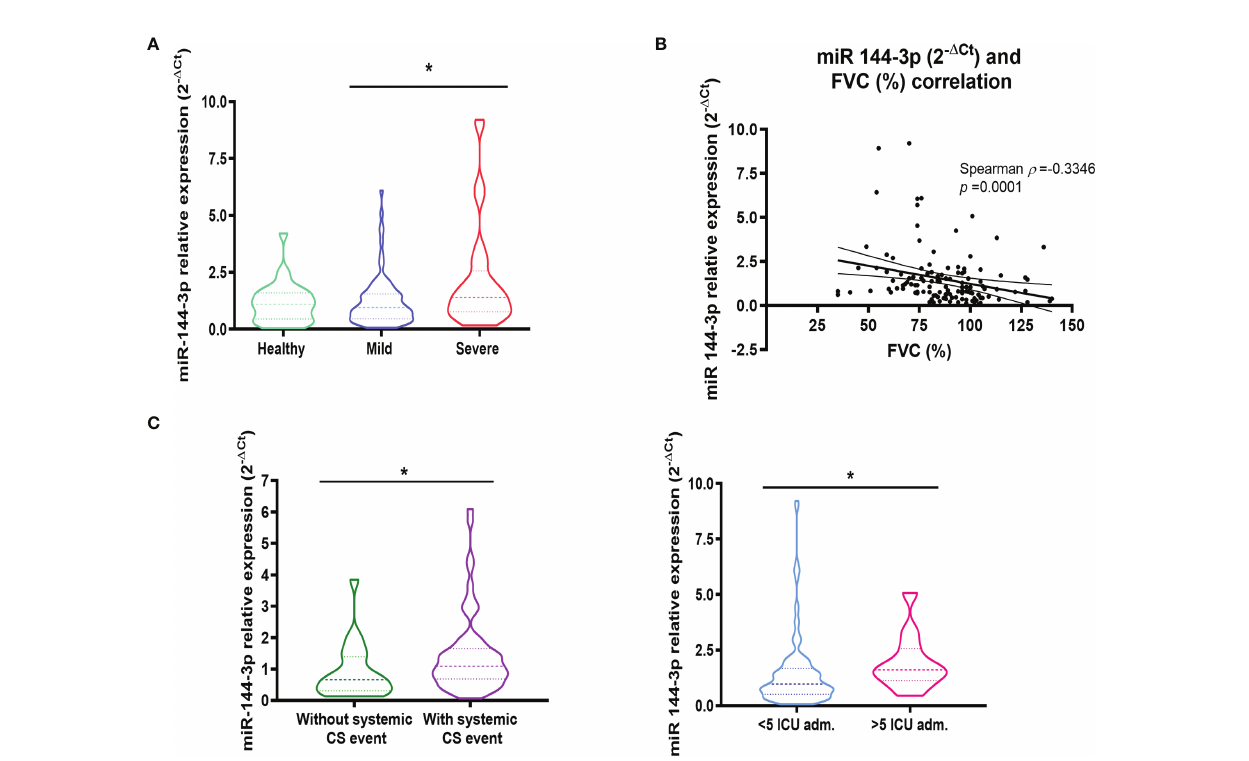
FIGURE 2 | The expression of miR-144-3p in serum is related to severe asthma. (A) The relative miRNA expression of miR-144-3p (2 - D Ct ) in serum is higher in severe asthmatics compared to mild to moderate asthmatics. (B) Relative miRNA expression of miR-144-3p (2 - D Ct ) in serum correlates inversely with FVC (%). (C) miR-144-3p relative expression (2 - D Ct ) is increased in asthmatics with a systemic corticosteroid event, and asthmatics with more than fi ve ICU admissions. Results are shown as median and quartiles. * p < 0.05. FVC, forced vital capacity; CS, corticosteroids; ICU, intense care